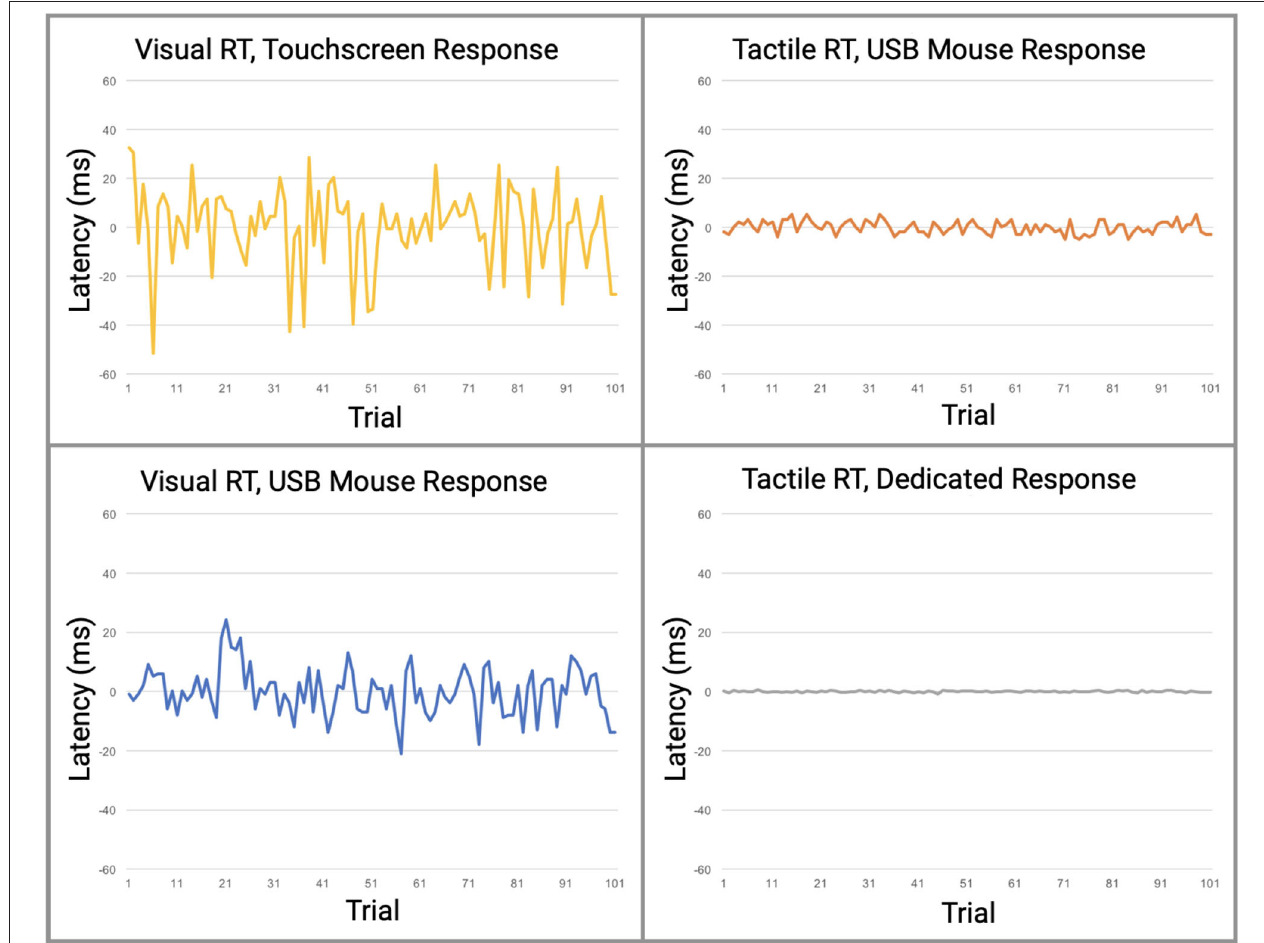
FIGURE 5 | Direct comparison of data from the four reaction time testing methods with averaged offset subtracted. Raw data is plotted with offset of median latency subtracted, a technique used by many reaction time assessments to adjust for systematic latencies. All data is plotted on the same scale. The visual task simulations had significantly greater variabilities than the tactile